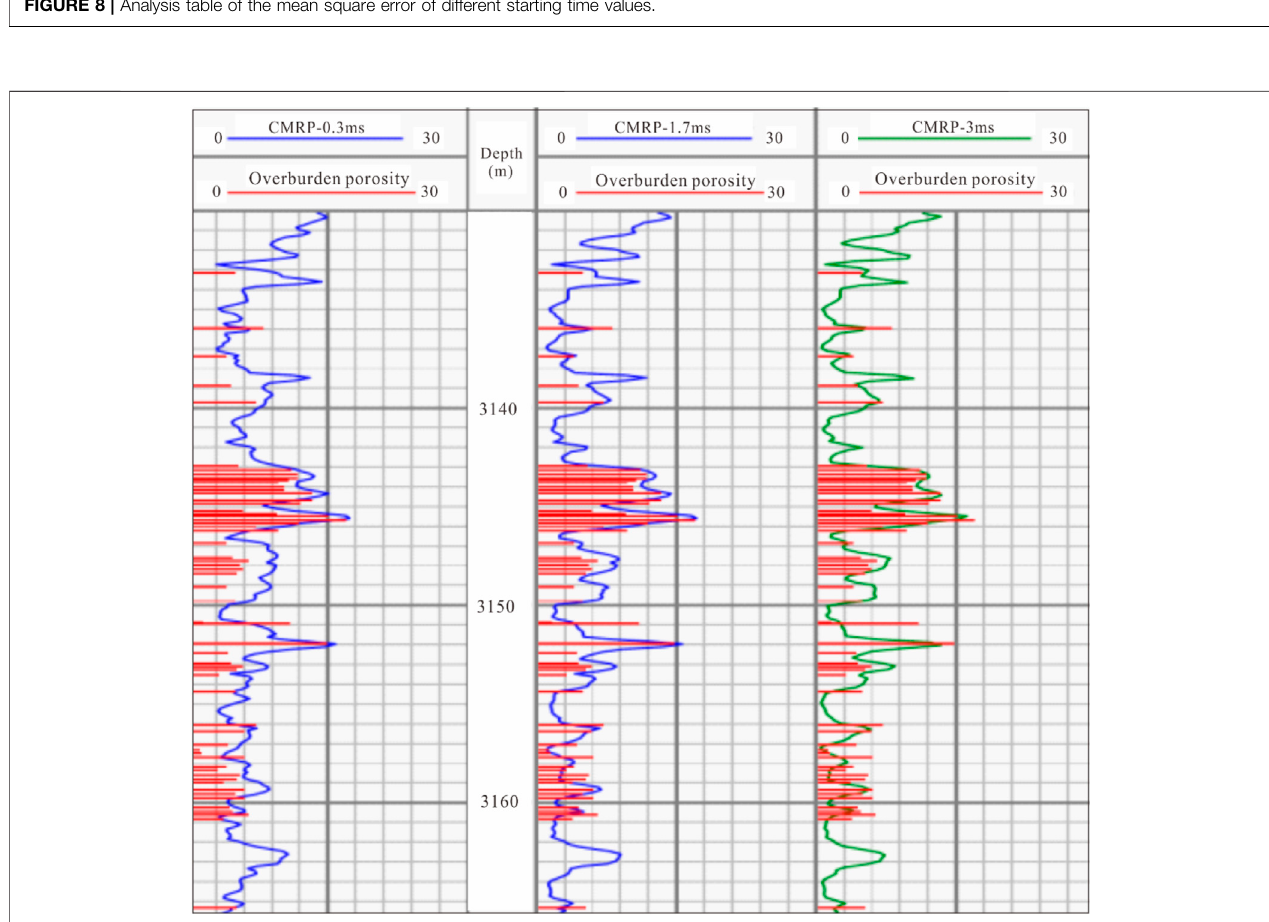
FIGURE 9 | NMR processing result of the X174 well.